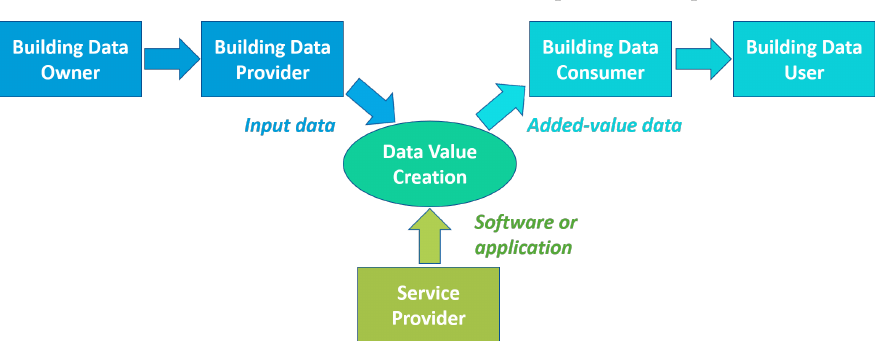
Figure 1. Data value creation within an IoT data-driven platform (adapted from [49]).